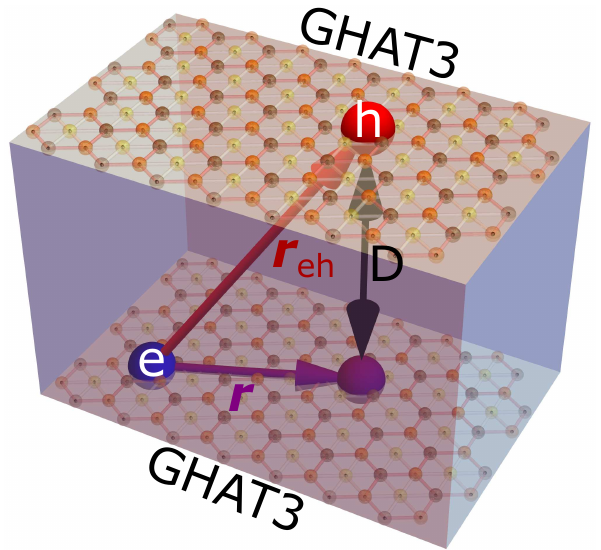
Figure 1. Schematic illustration of a dipolar excitonin a pair of GHAT3 double layers embedded in an insulating